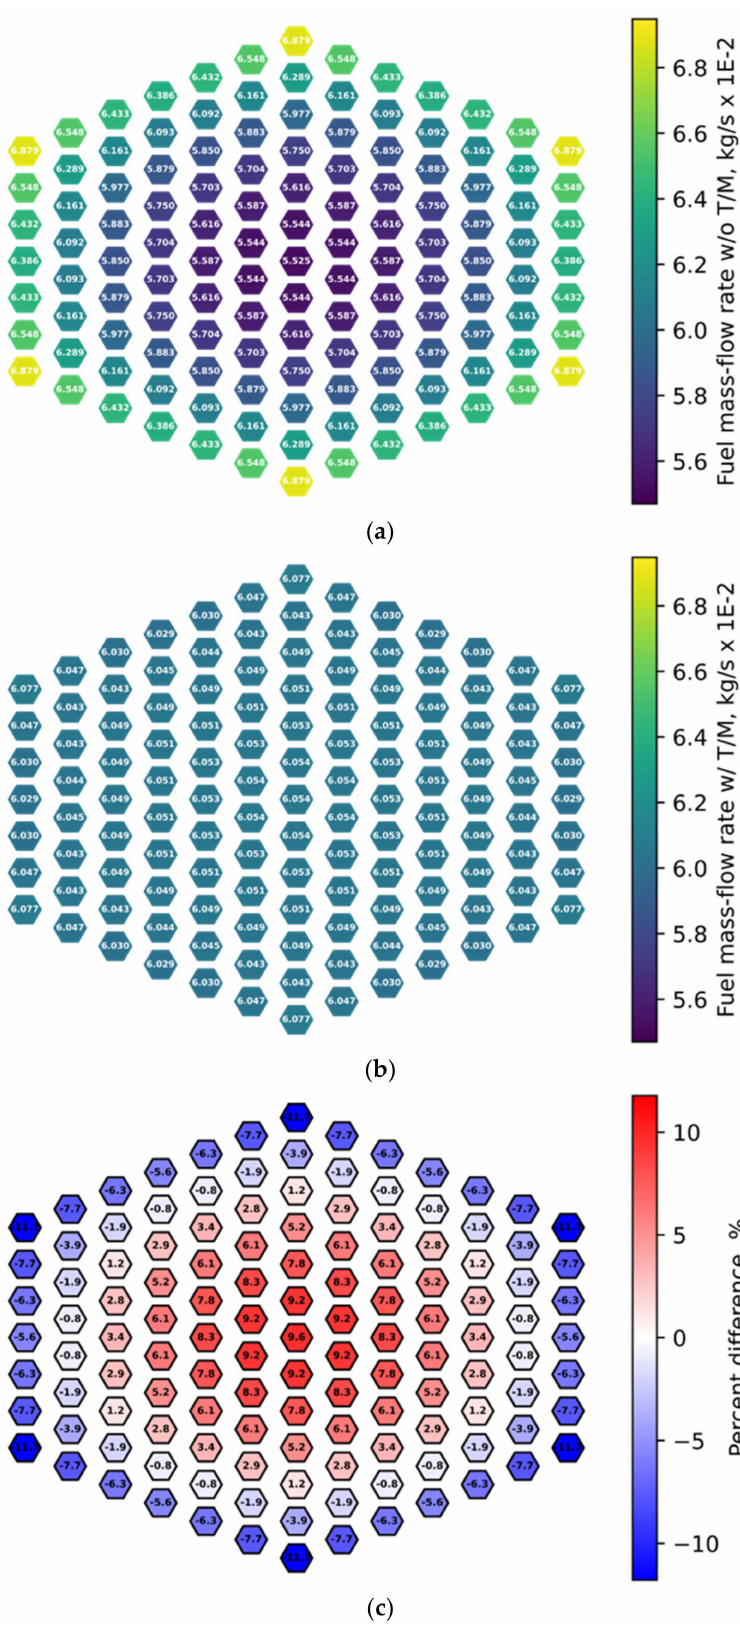
Figure 10. Comparison of mass flow rate ( a ) w/o T/M feedback; ( b ) w/ T/M feedback; ( c ) per- cent